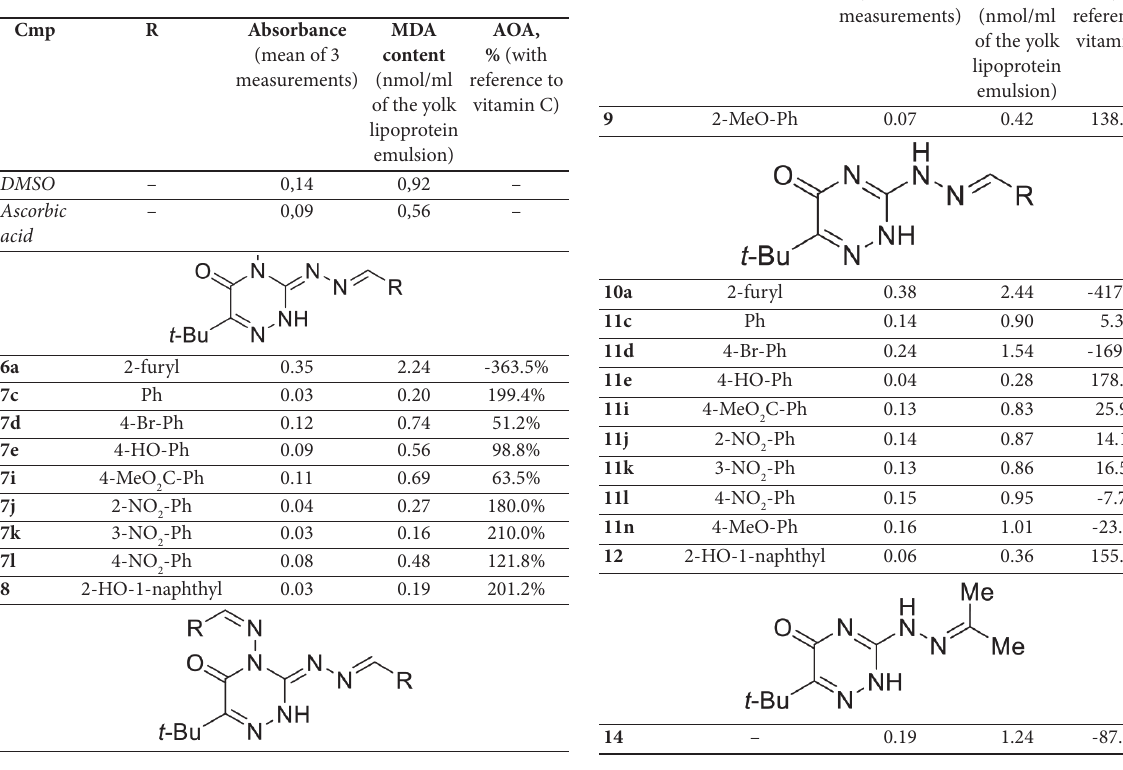
Table 1. Results of the antioxidant activity investigation of the synthesized